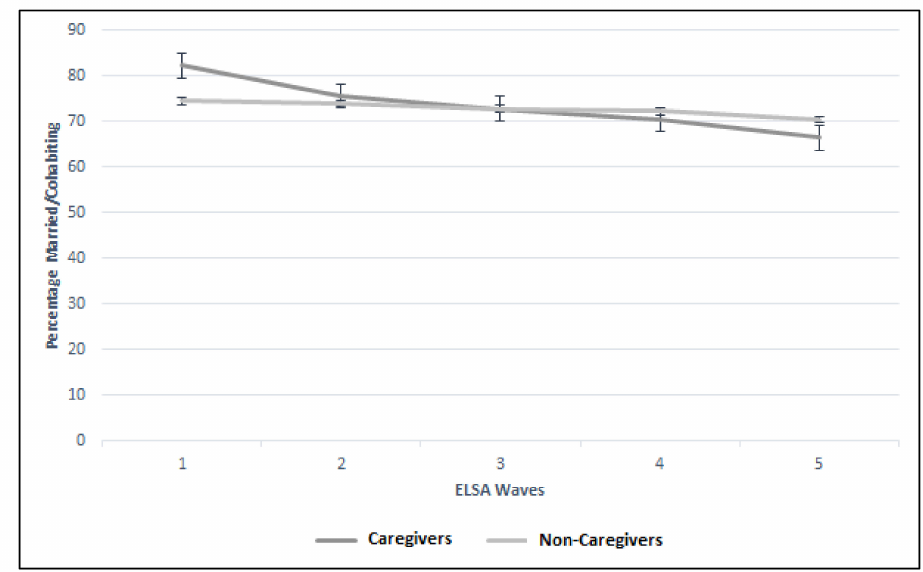
Figure 3. Trajectory of relationship status (married / cohabiting) between caregiver and non-caregiver cohorts across the five ELSA